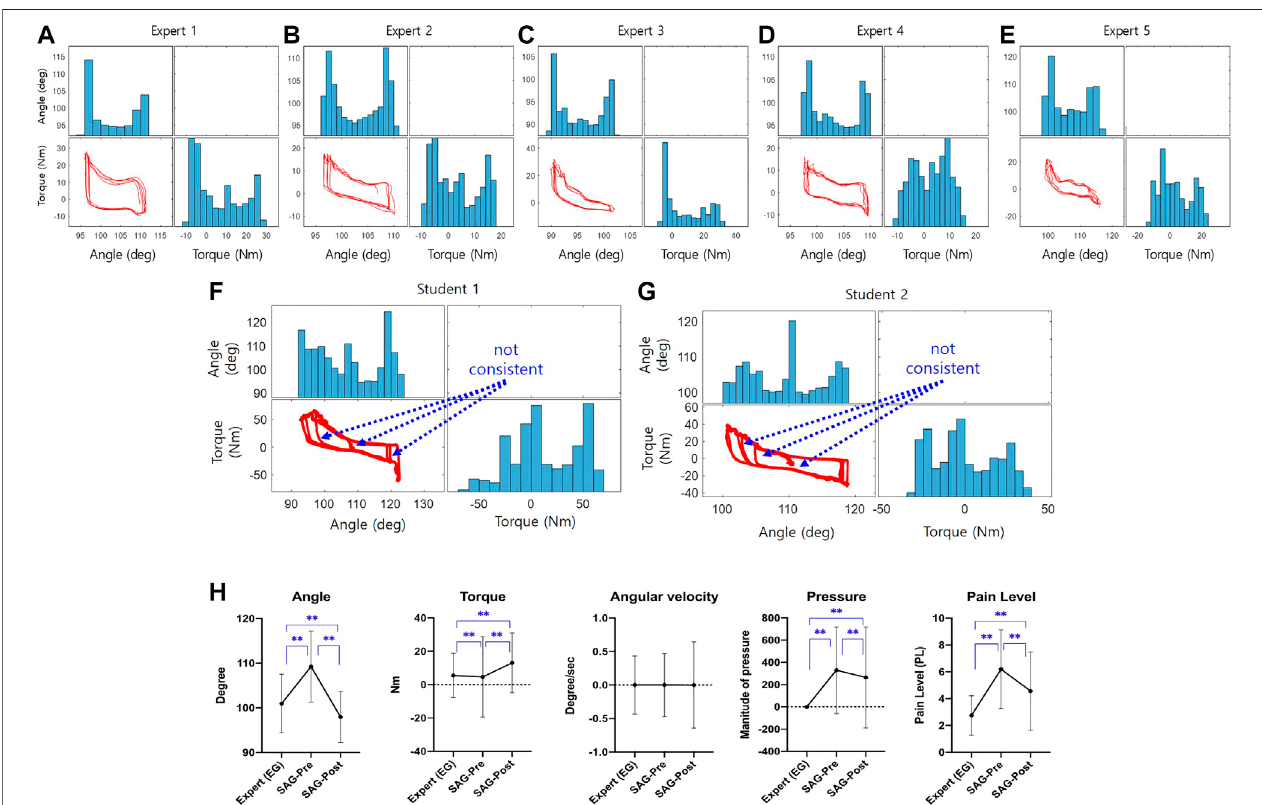
FIGURE 9 | The result of graph-based method: (A – G) plot matrixes of between angle and torque of the robot obtained when experts perform the ROM exercise, and from (A – E) denotes the expert #1 to #5, respectively (The graphs of blue bar and red plot represent the histogram and plot between external angle and torque, respectively.); (H) comparison result of statistical analysis of parameters as angle, torque, angular velocity, pressure parameters, and pain level (EG: expert group; SAG: student group when using CaTARo with care training monitoring). * p 0.05 and ** p 0.001.